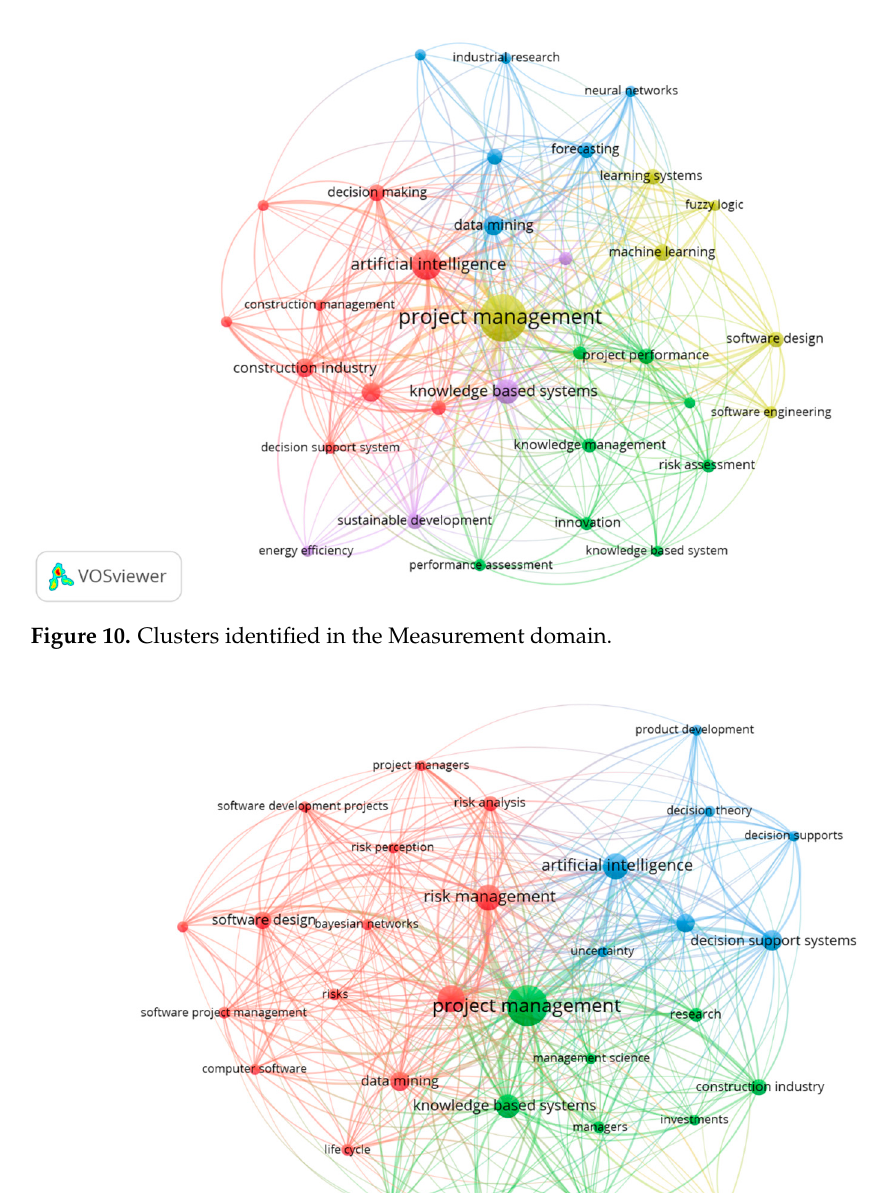
Figure 10. Clusters identified in the Measurement domain.